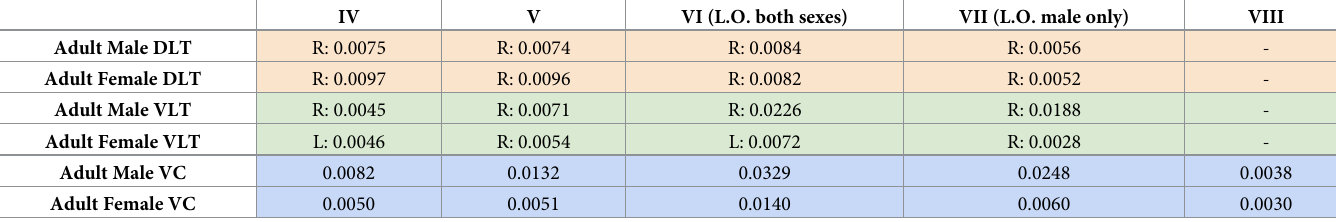
Table 4. Volume of Tracheal Features in Photinus pyralis (mm 3